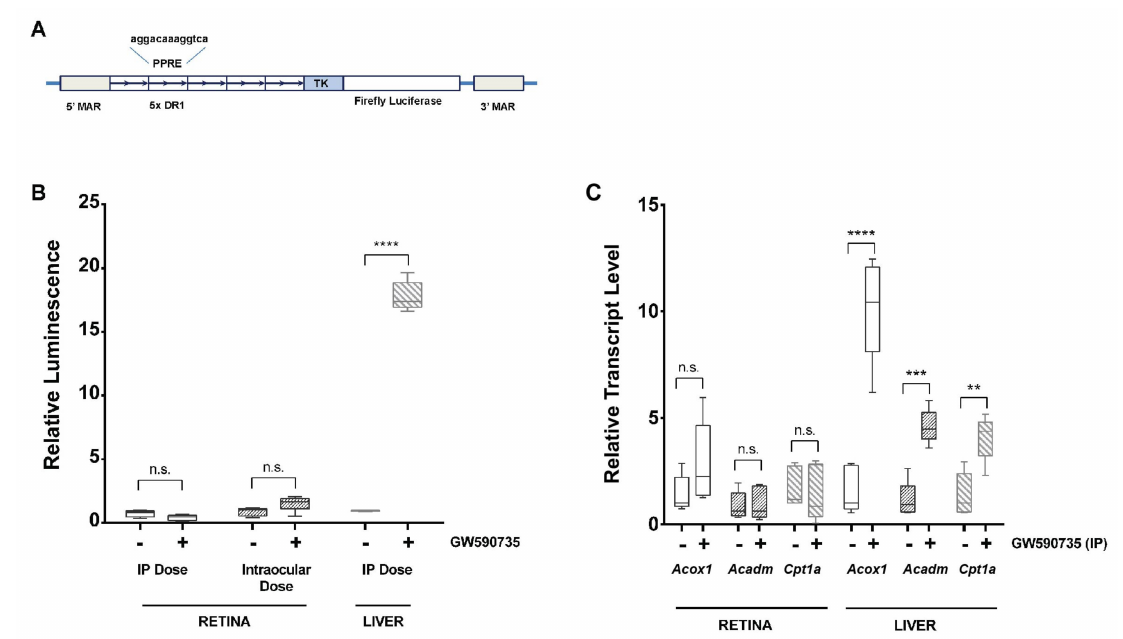
Figure 6. Systemic or local delivery of PPAR- α agonists activates a PPRE-Luciferase reporter in liver but not retina. ( A ) A construct consisting of five repeats of the peroxisome proliferator response element (PPRE) upstream of a basal thymidine kinase promoter (TK) driving the expression of firefly luciferase targeted to the nucleus with 5 (cid:48) and 3 (cid:48) matrix attachment regions (MARs) was used as a reporter to indicate activation of PPAR α locally within tissues. ( B ) Relative luminescence was measured in retinal and liver tissue isolated from six-month-old mice that had been treated with the PPAR α agonist GW590735. ( C ) No significant induction of reporter activity occurred in the retina following either intraperitoneal (IP) delivery of 10 mg/kg GW590735 or intraocular delivery of 2 µ L of 500 nM GW590735. However, robust induction was noted in the liver following IP injection of GW590735. Intraperitoneal injection of GW590735 led to increased expression of PPAR α -target genes Acox1 , Acadm , and Cpt1a in the liver, but not in the retina, as assessed using qPCR. n = 5 per group. Statistical significance was determined using two-way ANOVA with Bonferroni correction (** p < 0.01, *** p < 0.001, **** p <